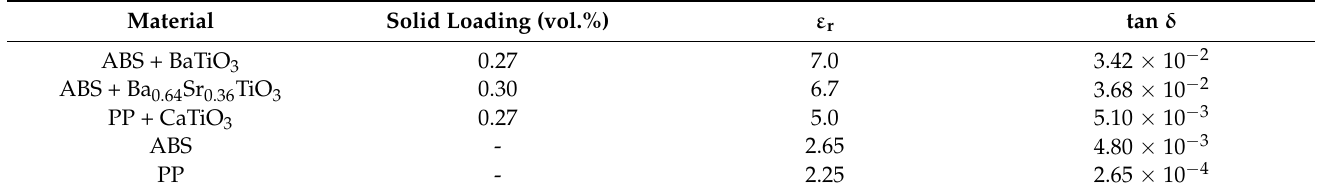
Table 2. Printed materials and their estimated and measured dielectric permittivity and losses at 15 GHz (Reprinted from Ref. [57], copyright (2016), with the kind permission of Elsevier). Material Solid Loading